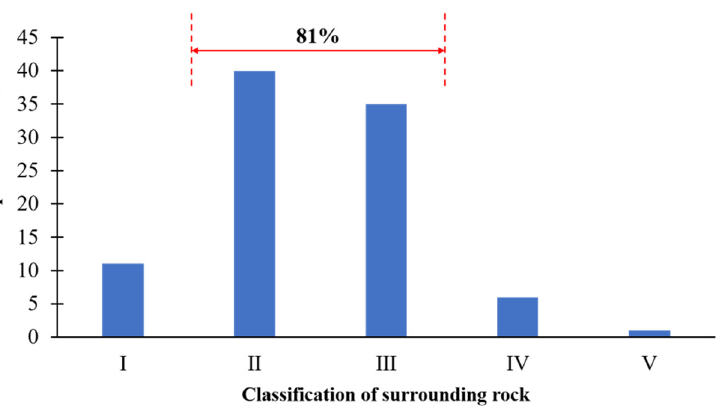
Figure 28. The distribution of surrounding rock classification ( Ⅰ, Ⅱ, Ⅲ, Ⅳ, Ⅴ are different surrounding rock classifications that reflect the quality of rock mass).